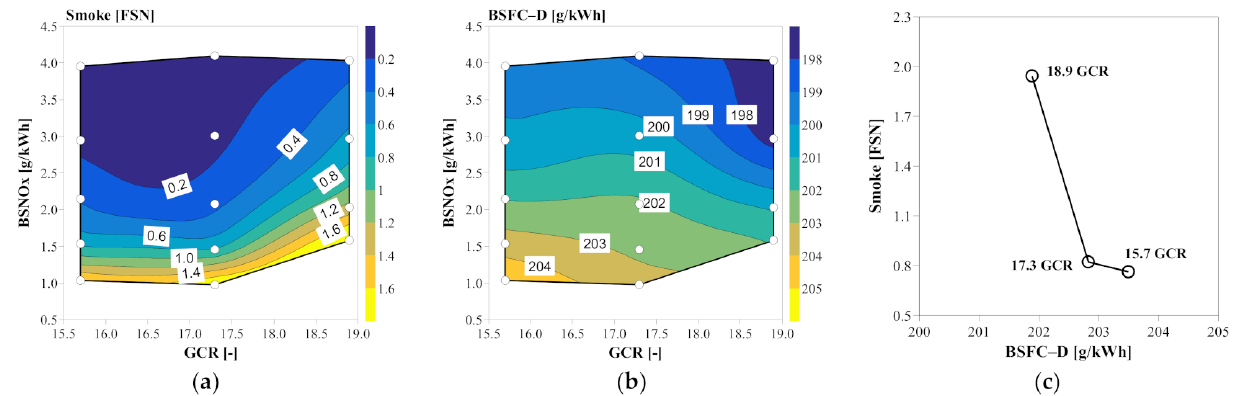
Figure 3. Impact of GCR and EGR on GCI performance in a 15 L heavy-duty diesel engine: ( a ) smoke; ( b ) BSFC-D; ( c ) BSFCV-D/smoke tradeoff.